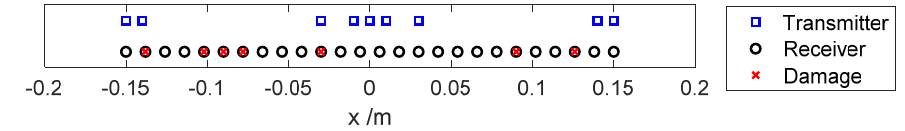
Figure 5. Array structure for simulation.